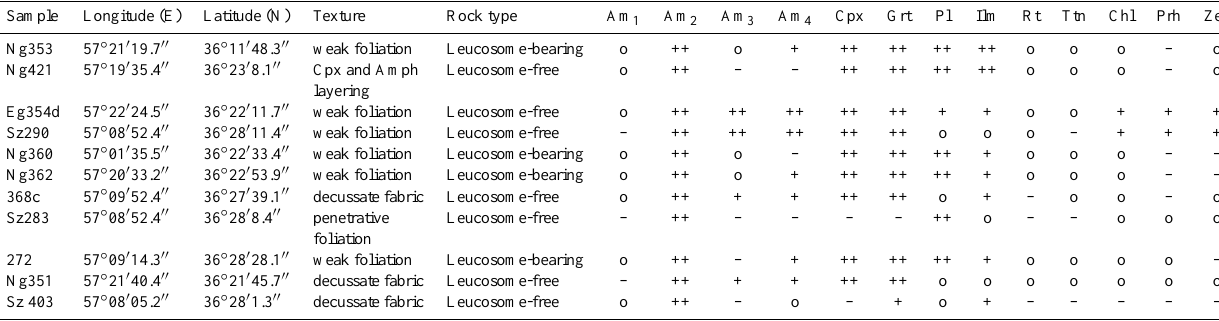
Table 1. Location, texture, and mineral assemblages of the studied samples. Sample Longitude (E) Latitude (N)